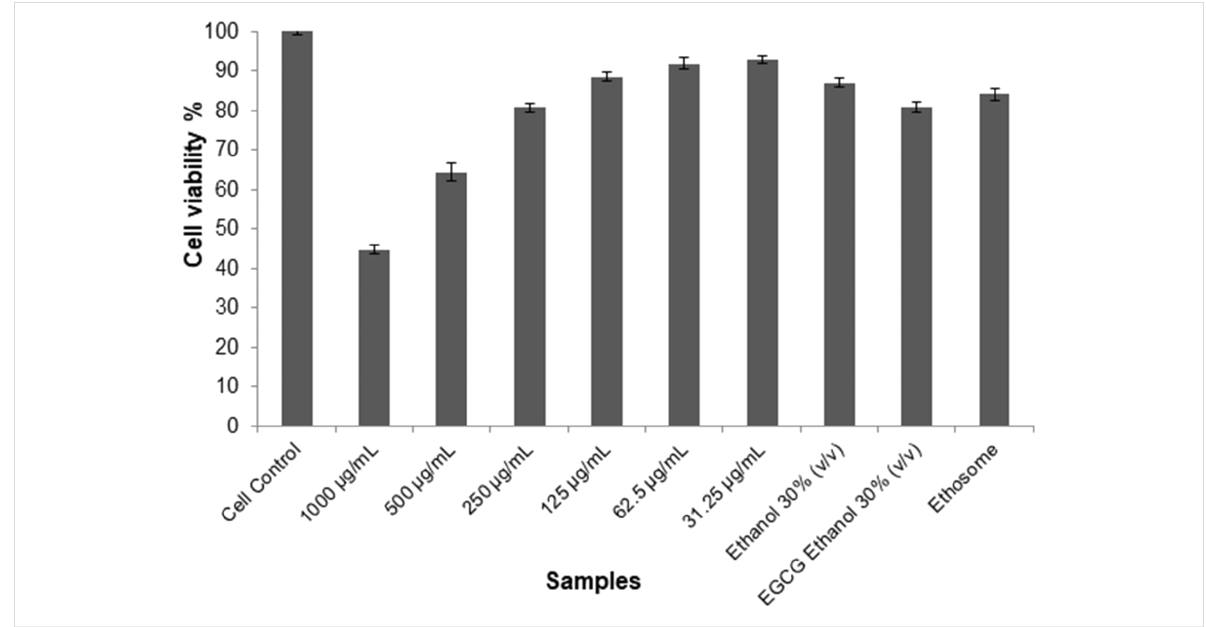
Figure 1: Percentage of cell viability of L929 cells incubated with samples for 24 h. (Values are expressed as mean ± standard deviation, n =